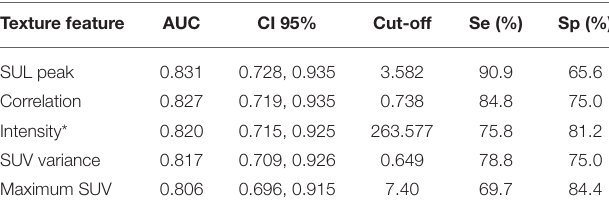
TABLE 3 | AUC values of five texture parameters and associated diagnostic performance parameters incorporated into the